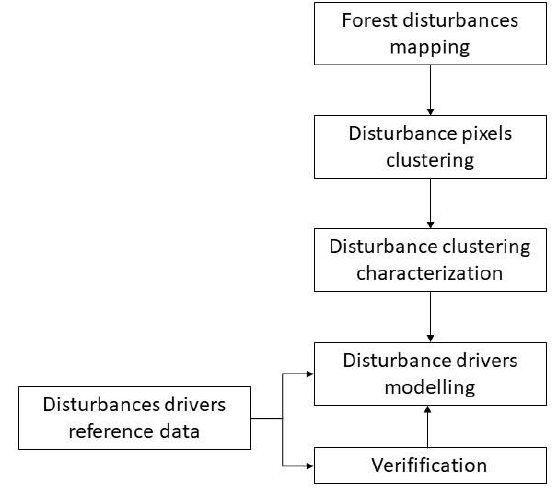
Figure 2. Diagram of the main method.